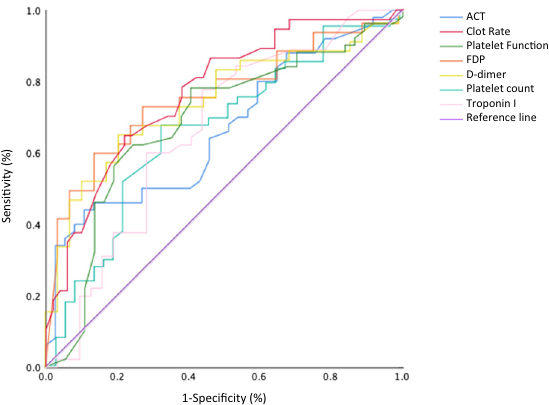
Figure 1: The ROC curves of ACT, CR, PF, FDP level, D - dimer level, platelet count, and troponin I level for ROSC in patients with